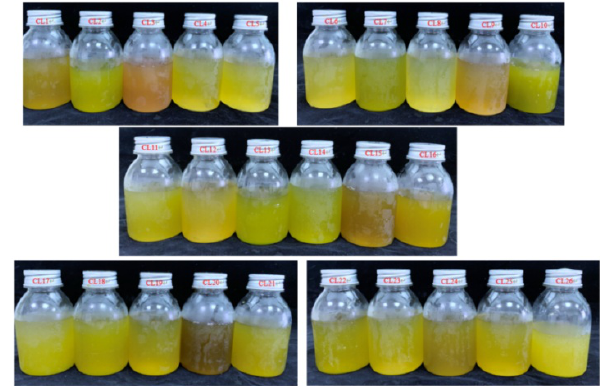
Figure 1. The pictures of celery juice made from 26 cultivars.